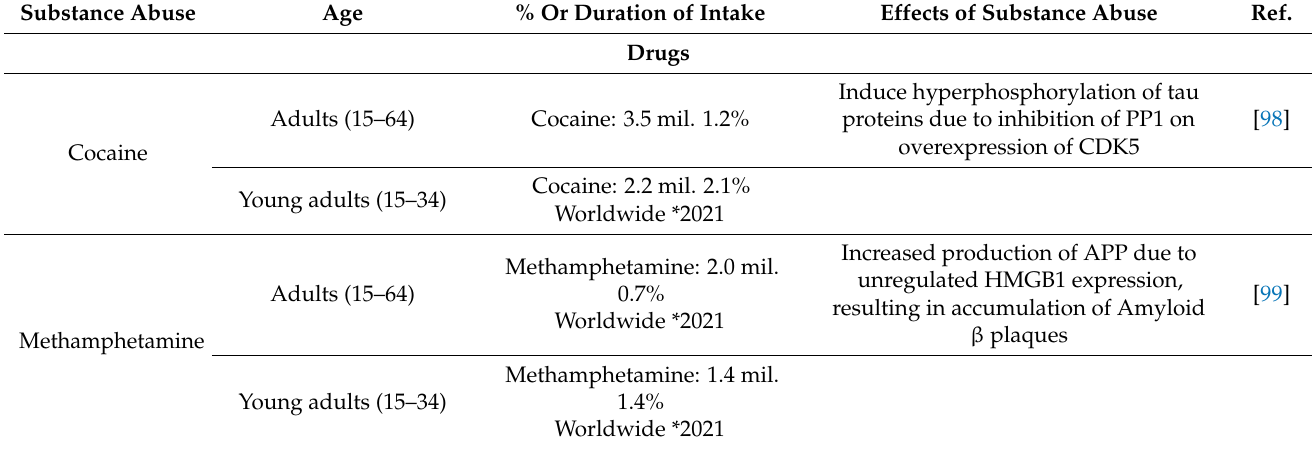
Table 5. Table for substance abuse: drugs, smoking, and